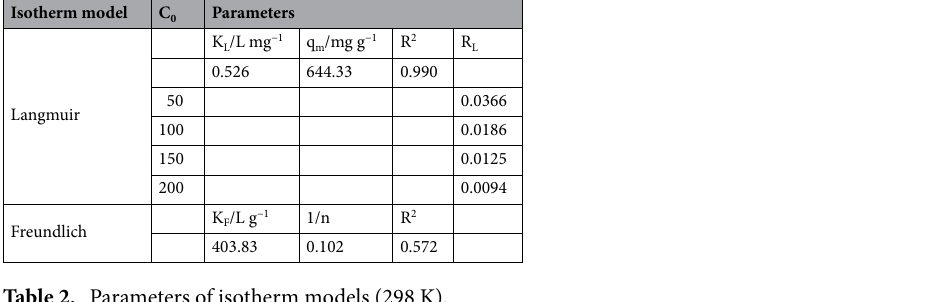
Table 2. Parameters of isotherm models (298